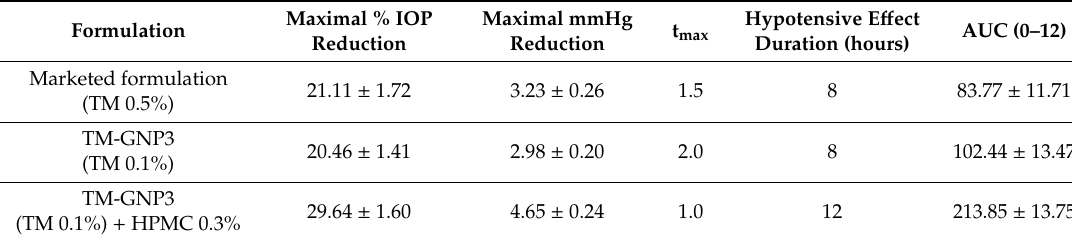
Table 6. Maximal % IOP reduction ± SEM; t max acquired by the median of first maximum e ff ect and AUC is the di ff erence of IOP (%) time curve from 0–12 h ±